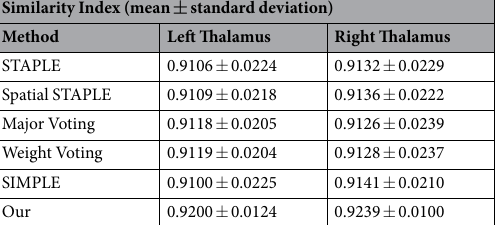
Table 2. The Similarity Index ( SI ) on the MICCAI dataset (mean ± standard deviation) for the various segmentation methods as compared with manual